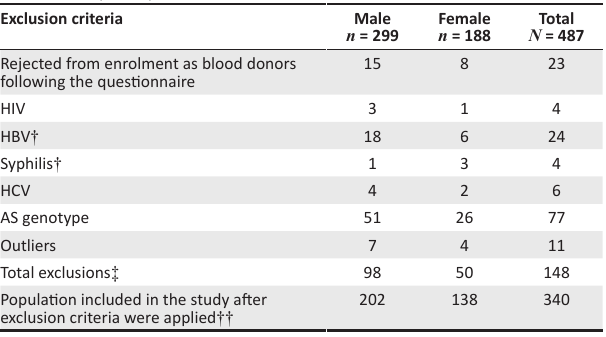
TABLE 1: Exclusion criteria applied to the blood donor population, Bamenda, Cameroon, April-September